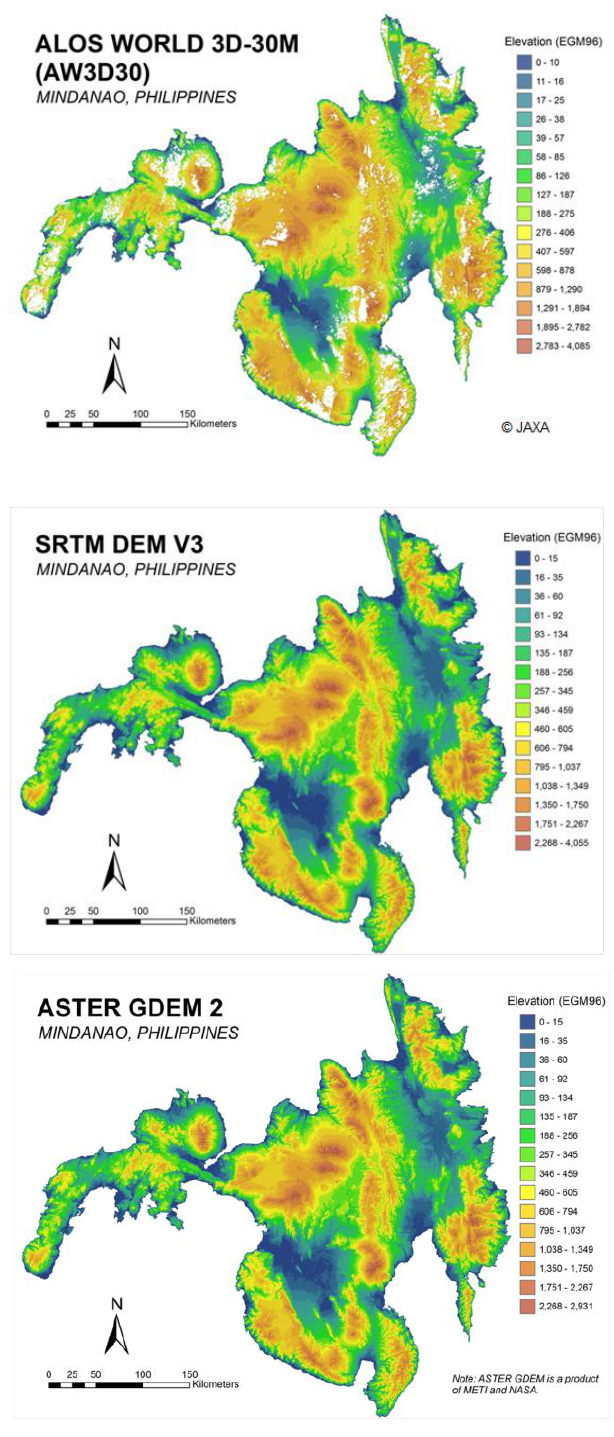
Figure 2. The three DEMs of Mindanao Island,